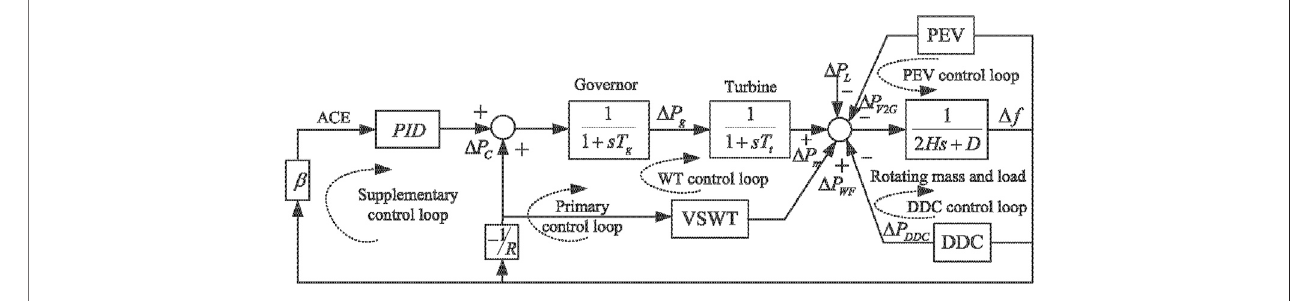
FIGURE 1 | The structure of the frequency regulation of the power